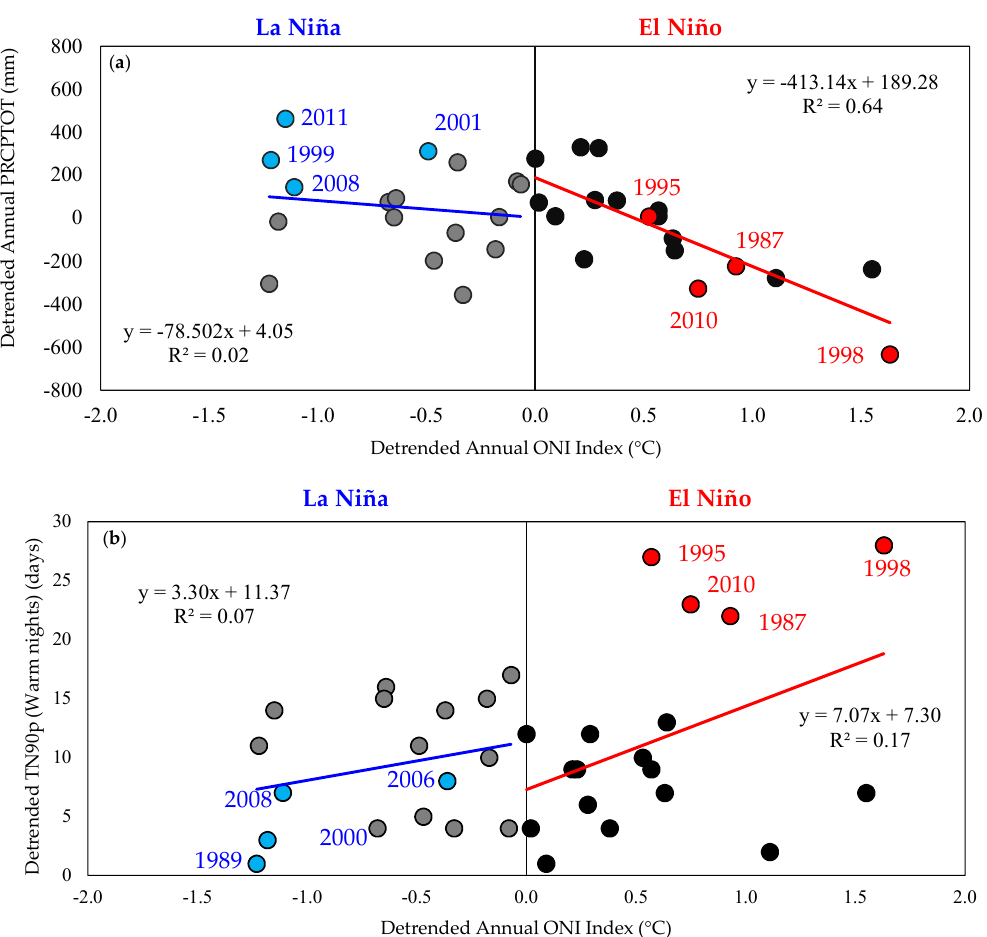
Figure 11. Comparison of NOAA Sea Surface Temperature Anomaly for Oceanic Nino Index Region 3.4 between ( a ) annual total precipitation (PRCPTOT), and ( b ) warm nights (TN90p). (https://climatedataguide.ucar.edu/climate-data/nino-sst-indices-nino-12-3-34-4-oni-and-tni).